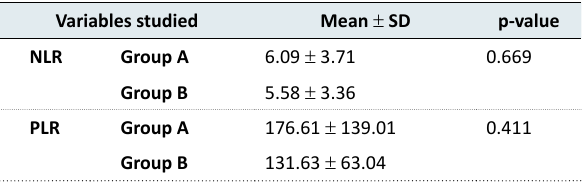
Table 2: Neutrophil to lymphocyte ratio (NLR) and platelet to lymphocyte ratio (PLR) between the